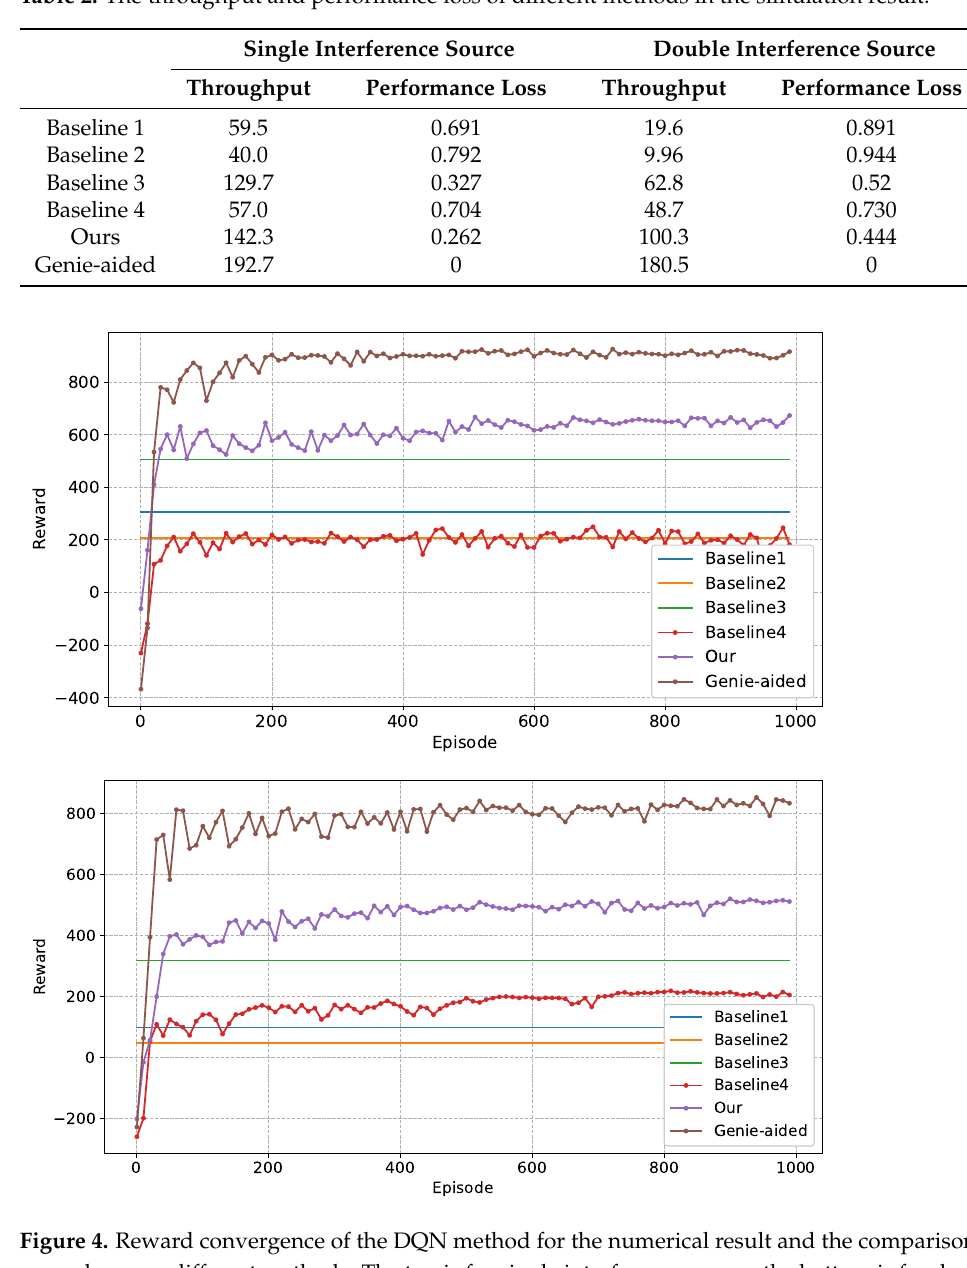
Table 2. The throughput and performance loss of different methods in the simulation result.